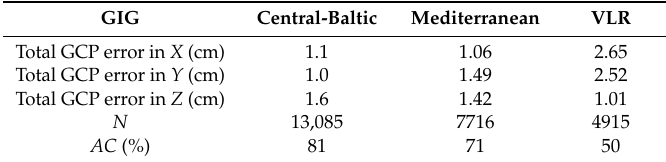
Table 5. Parameters describing the coregistration errors and the overall performance in hydromorphological feature identification for each of the Geographical Intercalibration Group (GIG) sites. N and AC stand for the number of points in the 2 m × 2 m grid and the accuracy in feature classification. GCP and VLR stand for Ground Control Point and Very Large Rivers,